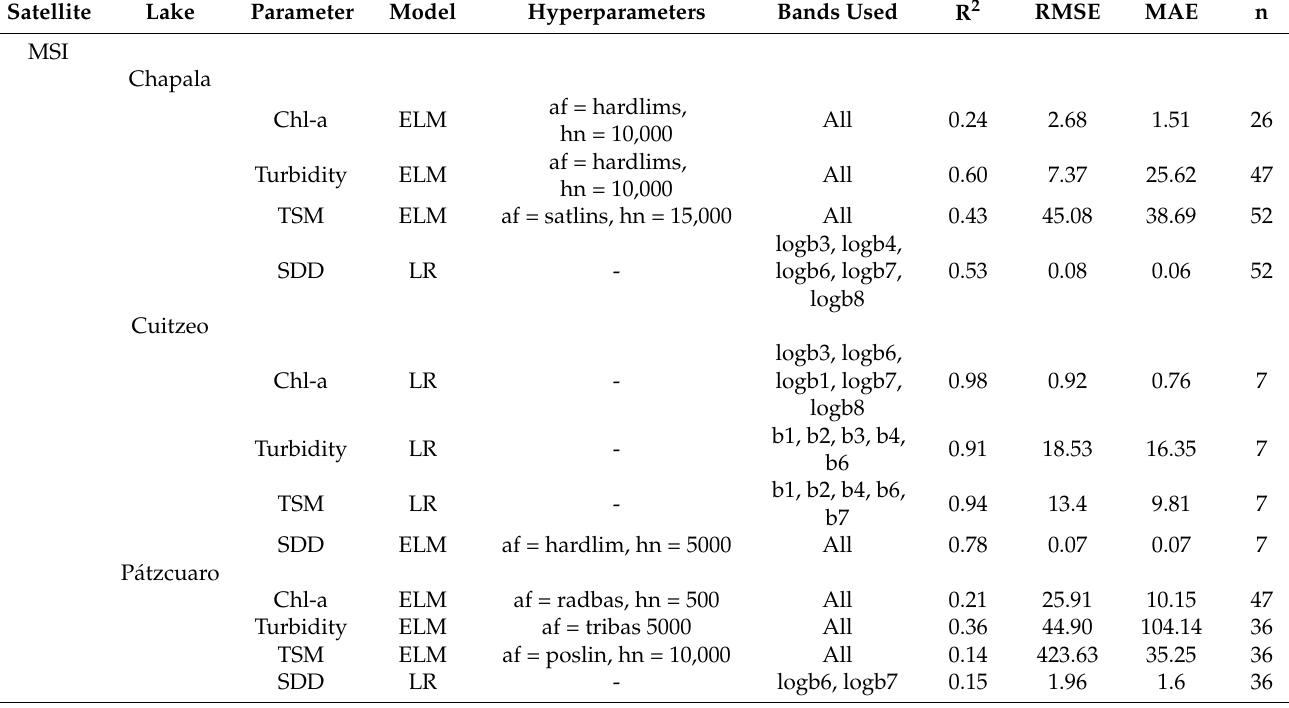
Table A6. MSI Model validation and predictive capability results for all datasets including coefficient of determination (R 2 ), root mean square error (RMSE), mean absolute error (MAE), and the number of samples